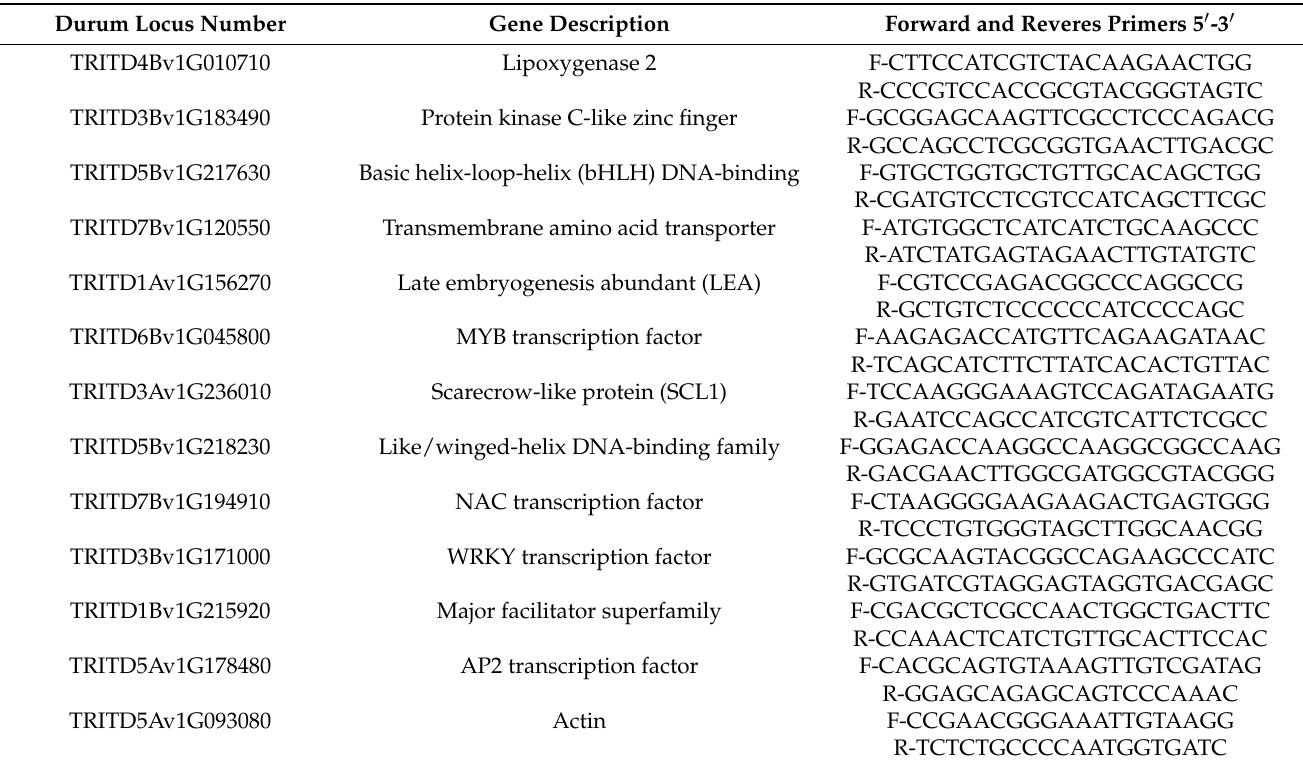
Table 1. List of investigated dehydration stress memory genes in durum wheat ( Triticum turgidum L. ssp. durum (Desf.)) and their description and primer sequences used to amplify them using qPCR, the last one corresponds to the reference gene actin. Durum Locus Number Gene